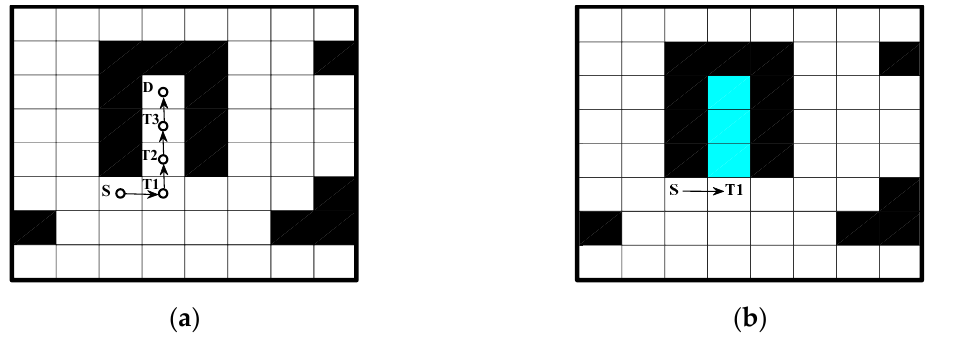
Figure 4. Deadlock handling strategy diagram; ( a ) Ant deadlock diagram; ( b ) Improved fallback strategy.